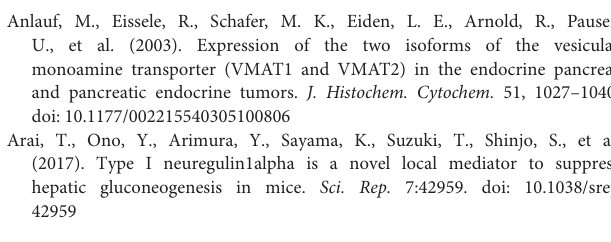
and figure design. DA: Experimental work and conception and figure design. RS: Manuscript writing, editing, synthesis of previous literature and figure